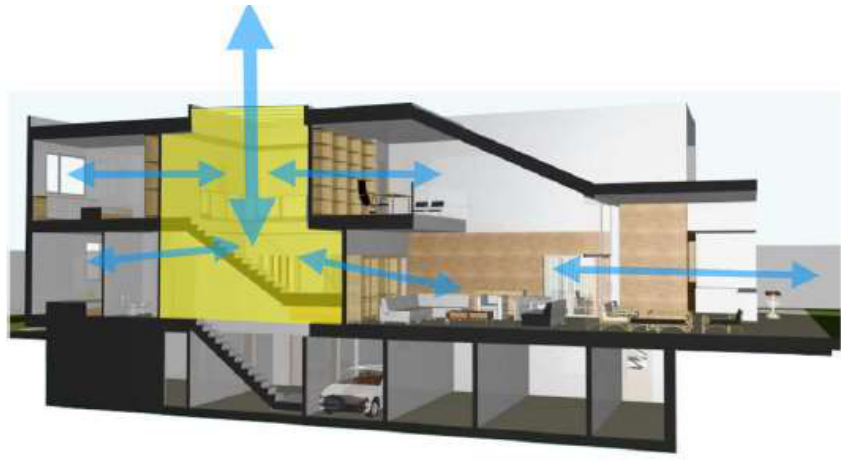
Figure 11. Cross-ventilation effect.